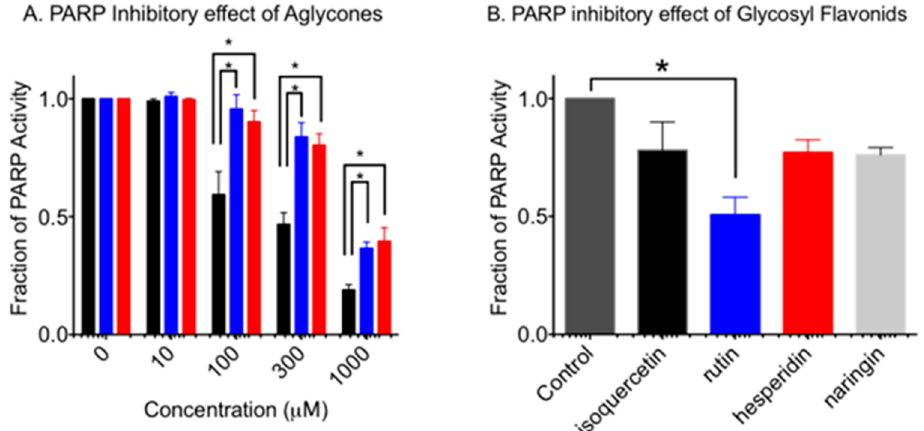
Figure 2. PARP activity inhibition by flavonoids. ( A ) Aglycone form of flavonoids at concentrations between 10 µM and 1000 µM. Black bars indicate quercetin. Blue bars indicate naringenin. Red bars indicate hesperetin. ( B ) Glycosyl form of flavonoids at the concentration of 1 mM. Mean values and standard error of the means from at least three independent experiments are plotted. * indicates statistically significant differences ( p < 0.05).